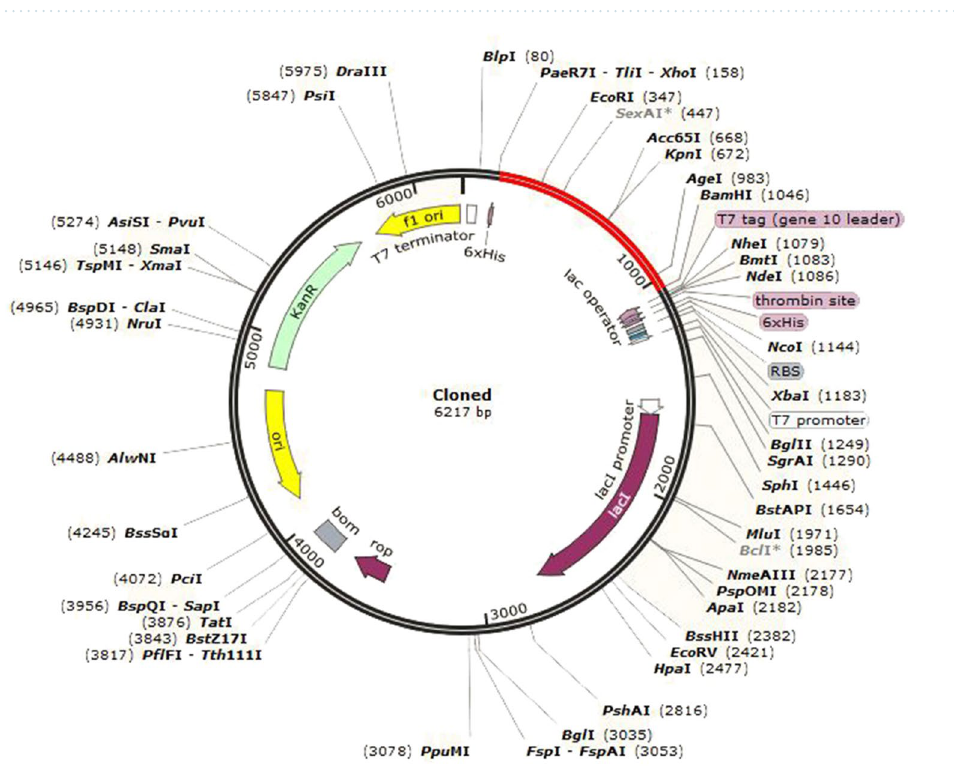
Figure 11. In silico cloning of the multi-epitope vaccine into the pET28a (+) vector using SnapGene sofware free-trial (https:// www. snapg ene. com/ free- trial/). The red section represents the vaccine construct and the black section shows the backbone of the